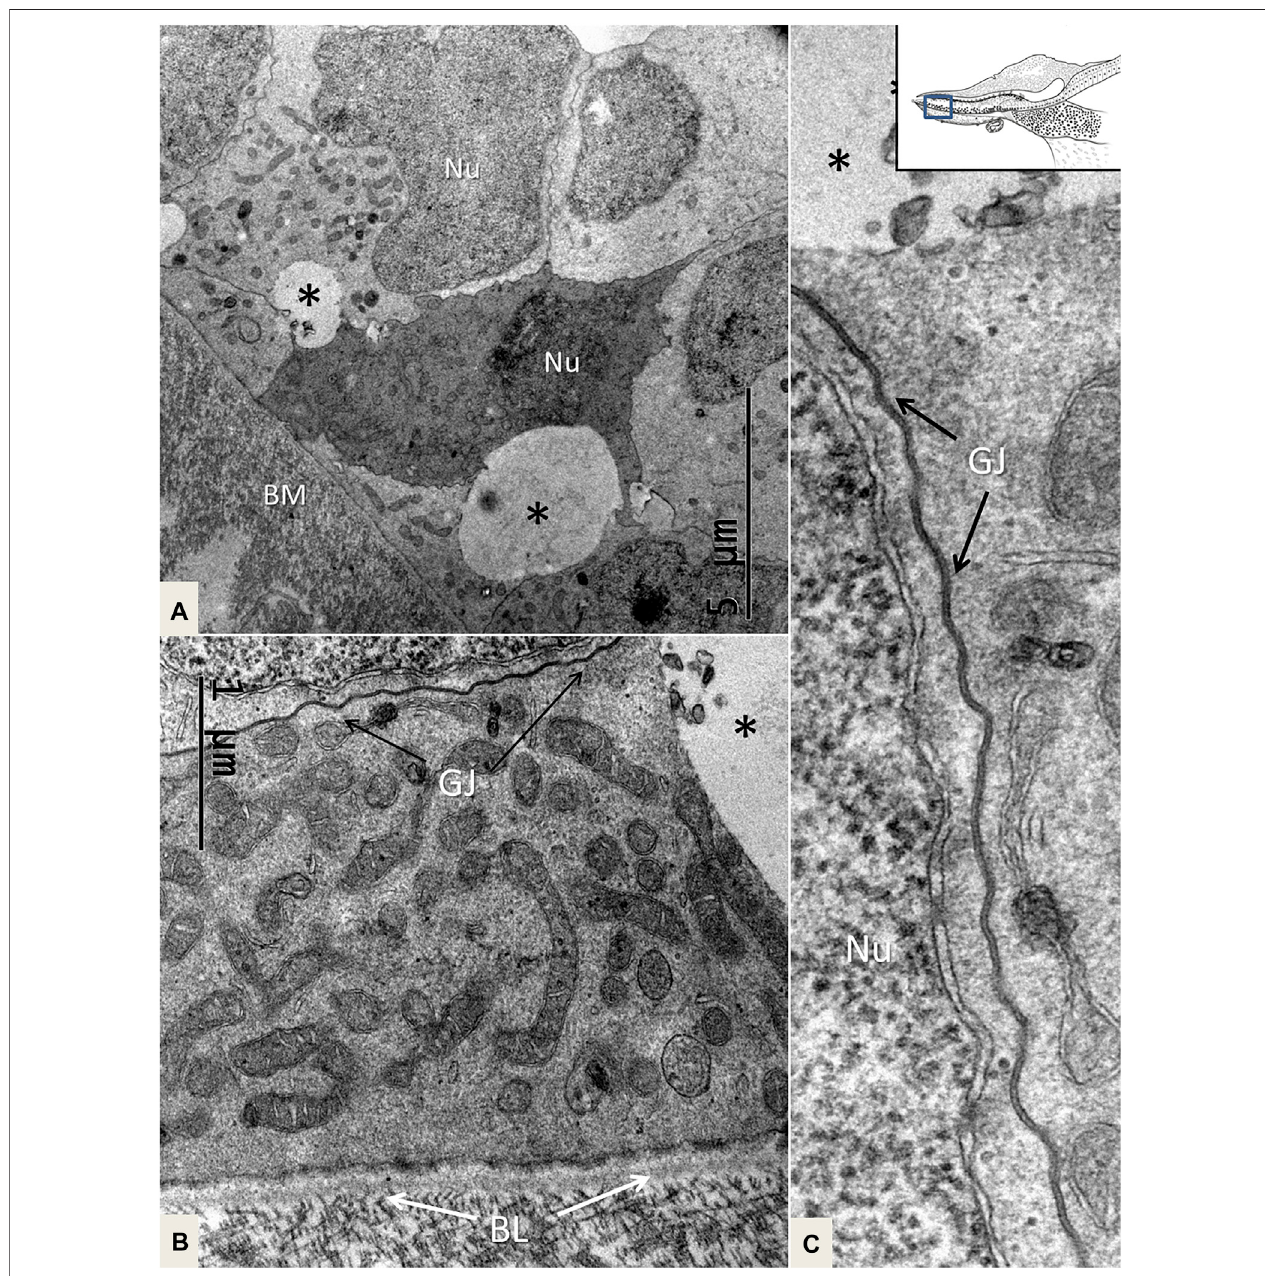
FIGURE 8 | TEM of mitochondria-rich SCs near the BM. One cell is more electron-dense, and there are clear intercellular vesicles (*). (B) . SCs display prominent GJs. (C) . Higher magni fi cation of an intercellular GJ shown in (B) . BL: basal lamina, Nu: nucleus.